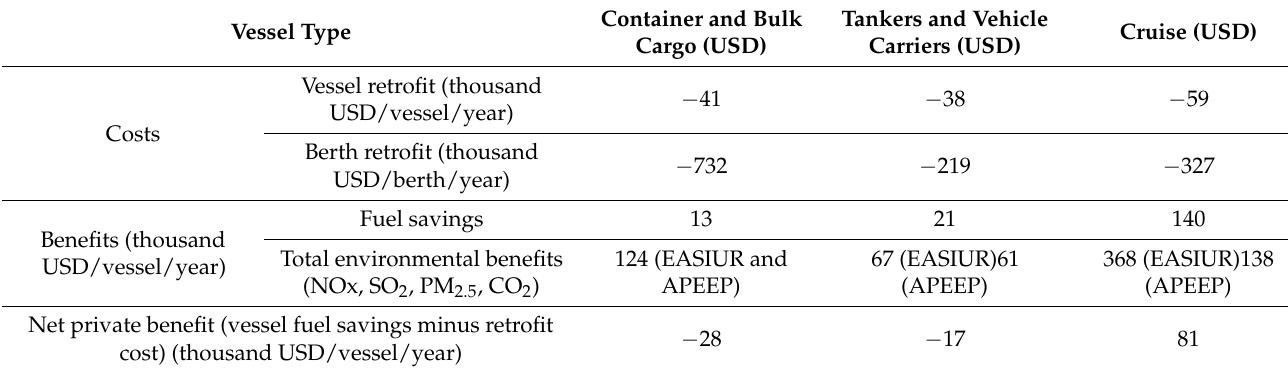
Table A31. Estimated costs of ESP (based on Table 1 in